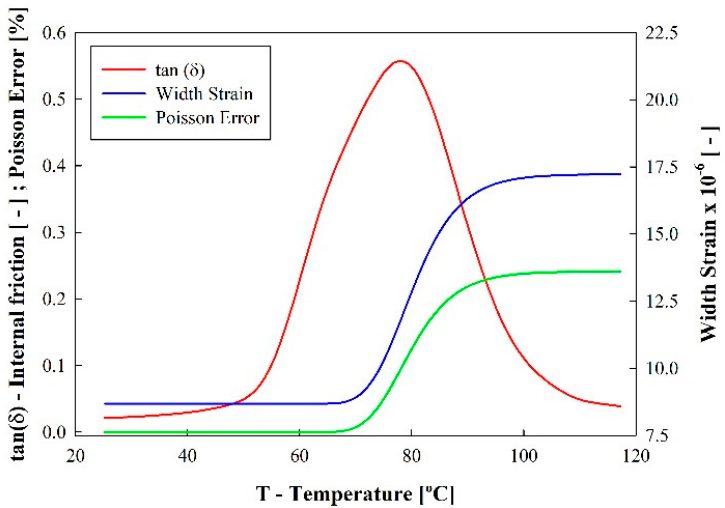
Figure 9. Graphical representation of results discussion.